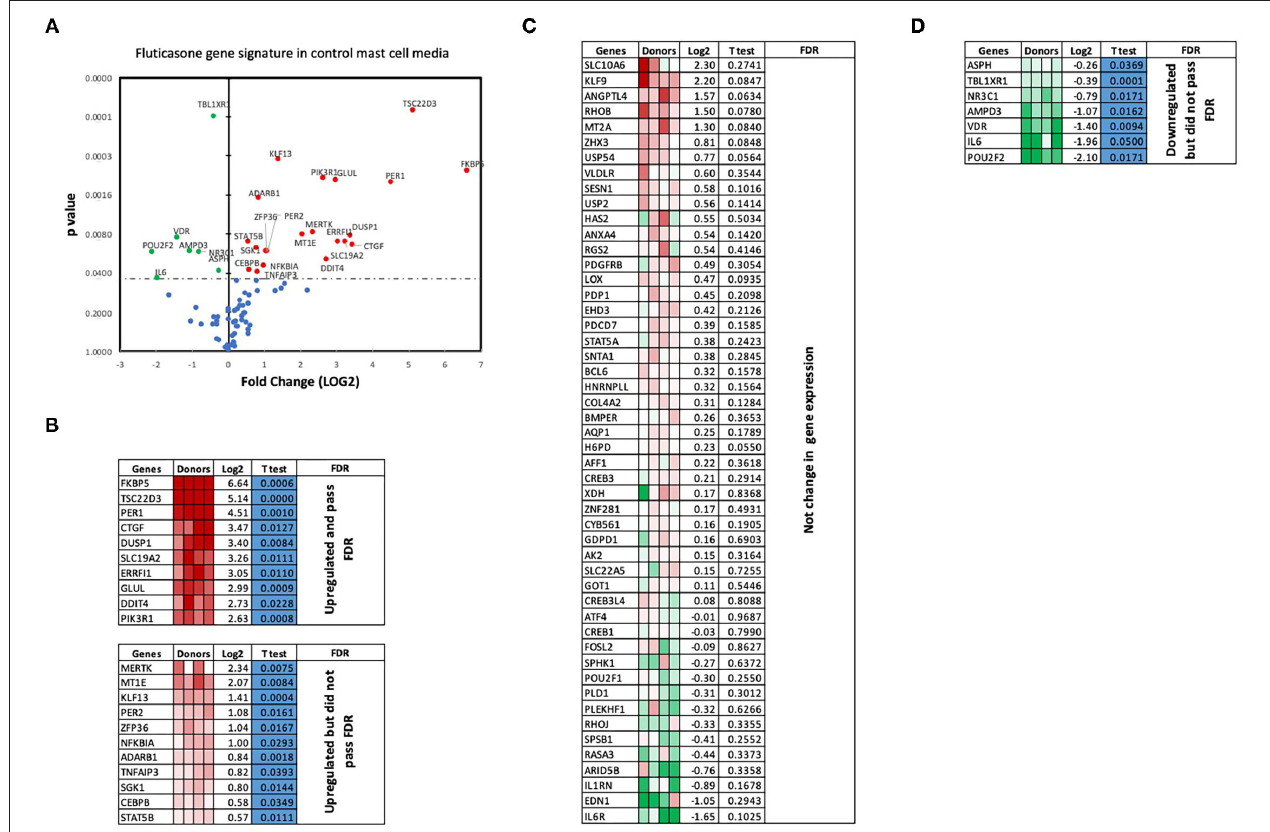
FIGURE 5 | Volcano plot and heatmap of fluticasone inducible genes in ASM cells detected using the PCR array in cells pre-treated with control media. Data are presented as statistical significance ( p -value) vs. fold change (log2 fold) on the y-axis and x-axis, respectively, in response to 100nM fluticasone for 6h in ASM cells first pre-treated with control mast cell media (A) . All genes were normalized to housekeeping genes (GAPDH and beta-actin and presented as fold Change (2 − 11 Ct , log2 fold). (B) Genes upregulated that did pass or did not pass FDR, (C) genes with no expression change, and (D) genes that were downregulated but did not pass FDR. Student’s t -test was used for statistical significance. All the data ( p -value) were then adjusted using the False Discovery Rate approach (FDR) with a cut off P <